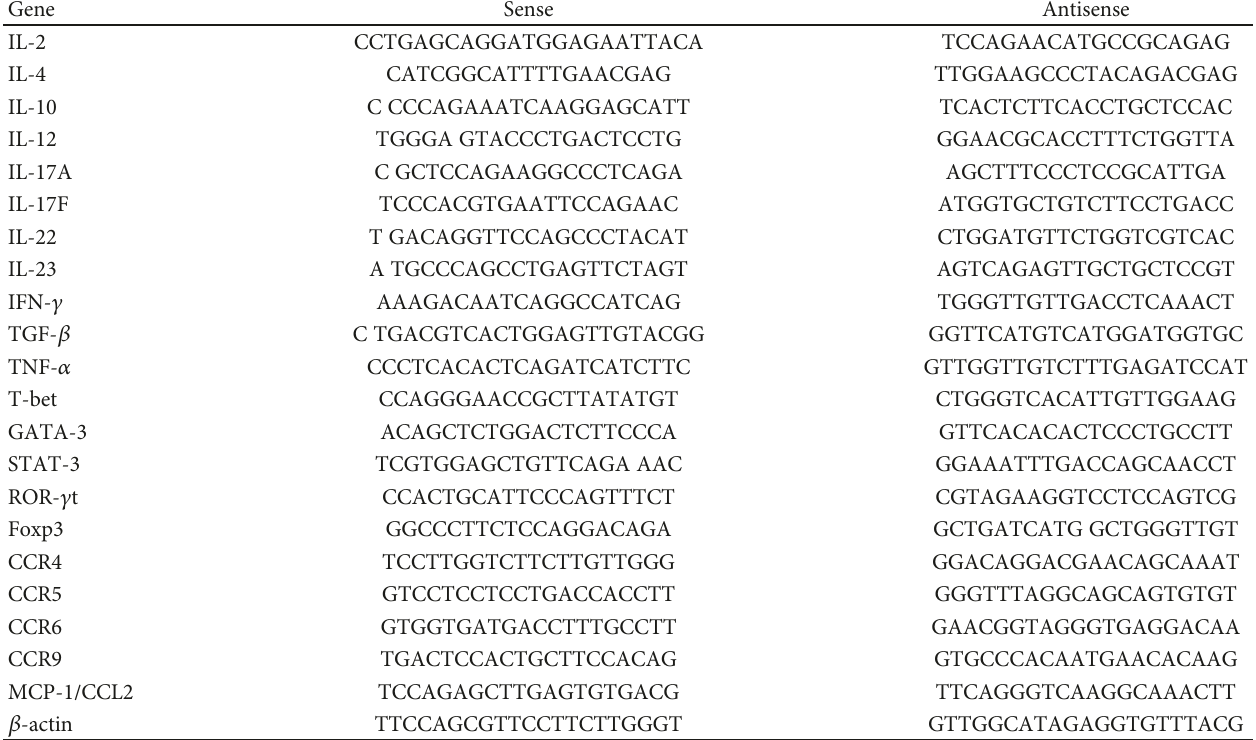
Table 1: Primer sequences used for real-time